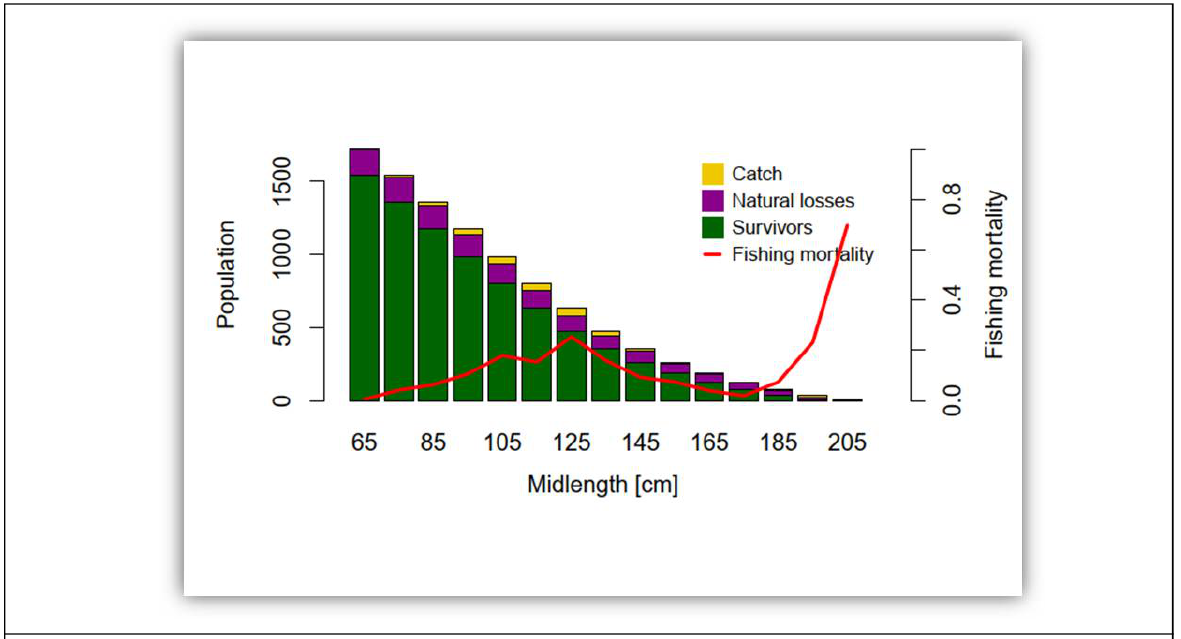
Figure 5: Virtual Population Analysis for Xiphias gladius in coastal waters of